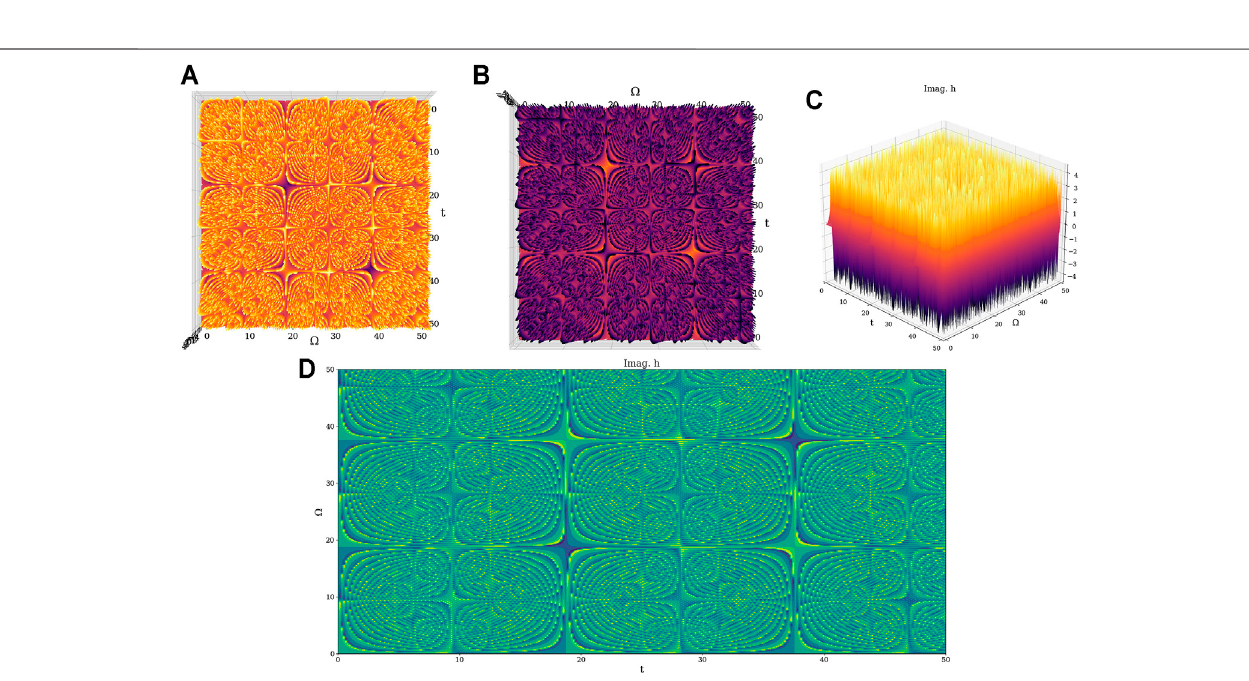
FIGURE 3 | Example 3D plot of Im [ h ( Ω , t )] ; (A) Φ (cid:2) 2 . 35, (B) (top, i.e., positive values); Φ (cid:2) 2 . 35, (C) (bottom, i.e., negative values); Φ (cid:2) 2 . 35 and (D) example 2D plot of Im [ h ( Ω , t )] ; Φ (cid:2) 2 . 35.